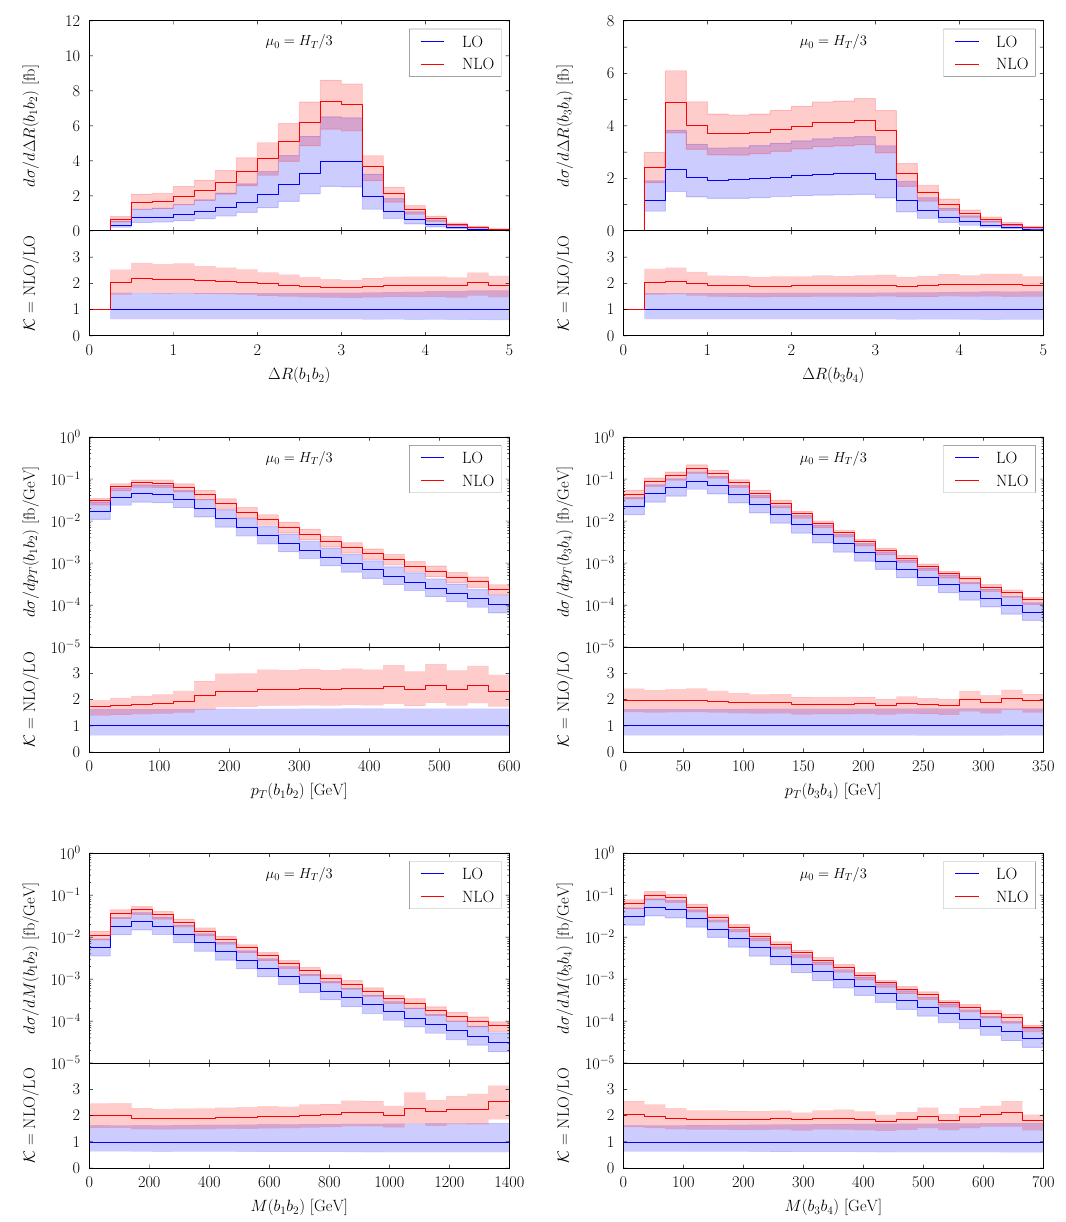
Figure 6 . As in figure 5 but for the ∆ R ( b 1 b 2 ) , ∆ R ( b 3 b 4 ) , p T ( b 1 b 2 ) , p T ( b 3 b 4 ) , M ( b 1 b 2 ) and M ( b 3 b 4 )